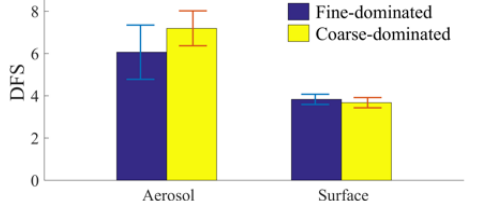
Figure 2. The mean and standard deviation of the total DFS presented in the format of a histogram with error bars for bare soil surface